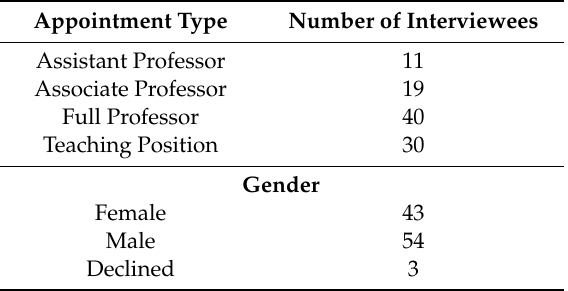
Table 1. Interview Sample